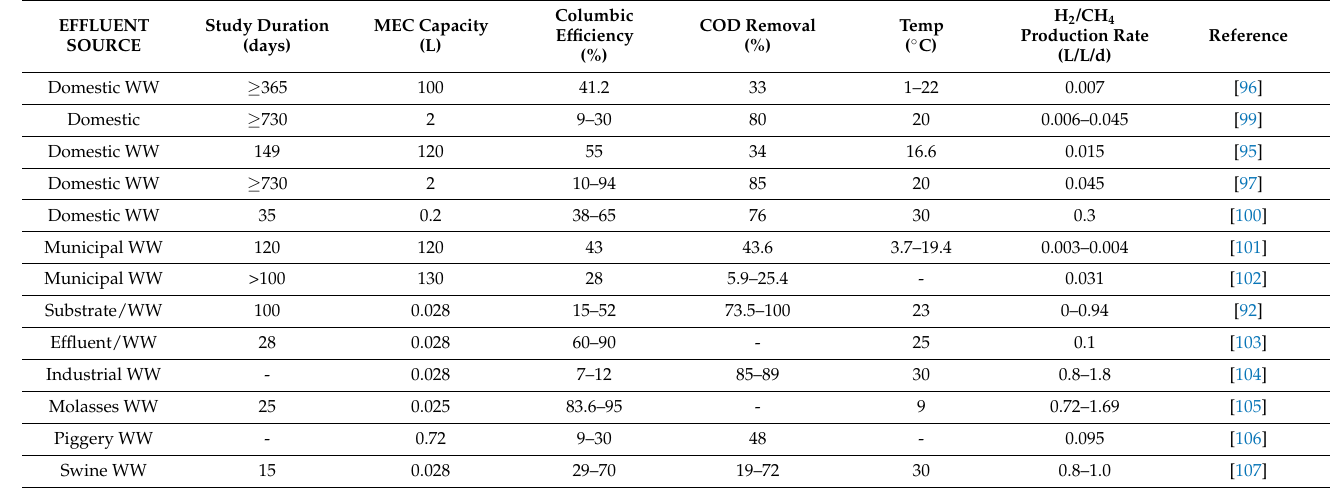
Table 10. H 2 production from wastewater through MEC.